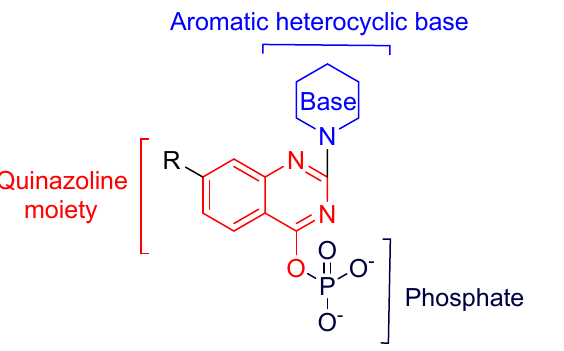
Figure 3. Replacement of sugar moiety with a quinazoline moiety for synthesis of new nucleoside analogues.